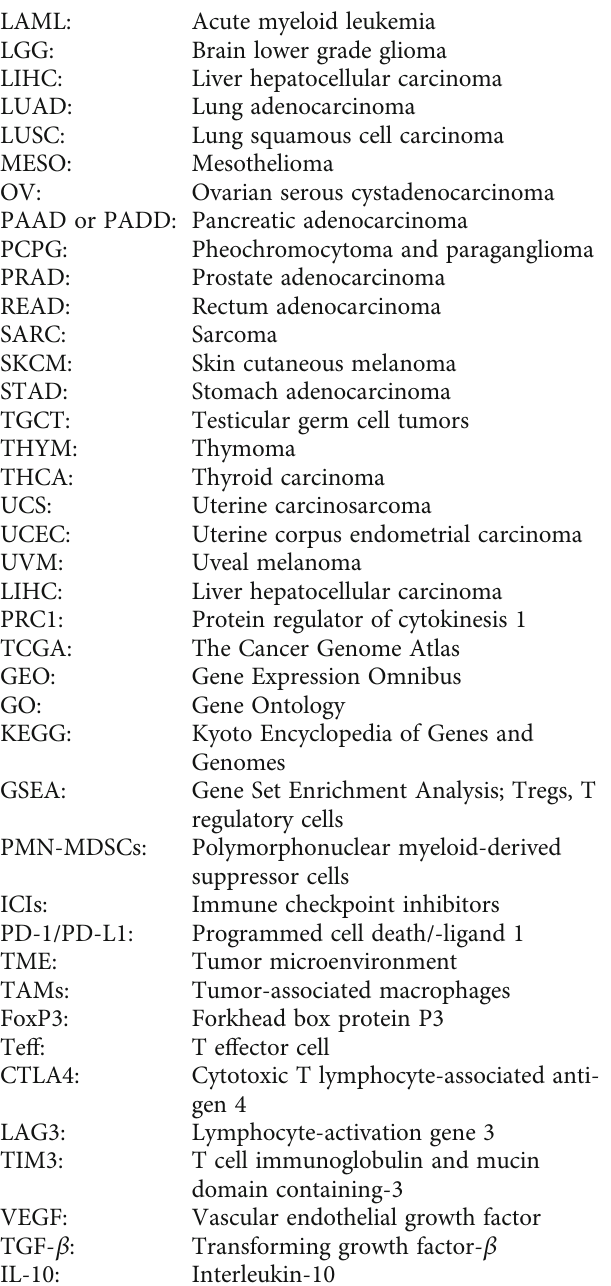
Figure 1 is drawn using the Figdraw online platform (http:// www. fi gdraw.com/)